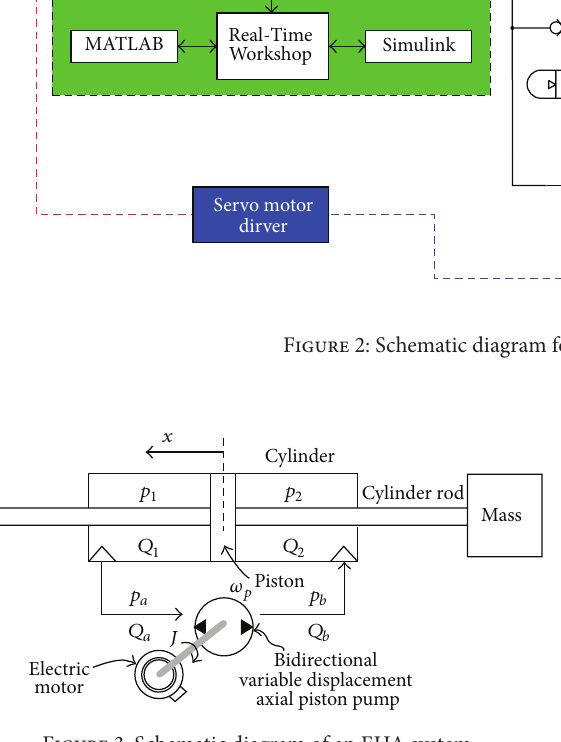
Figure 3: Schematic diagram of an EHA